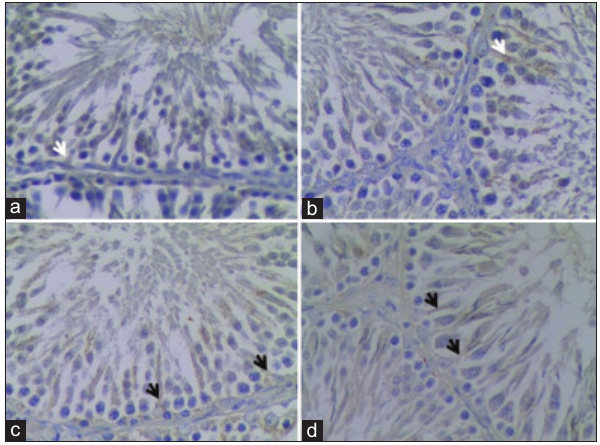
Figure-1: Micrographs of rat testicular tissue (original magnification, ×400). (a) The control group, (b) injected with 25 μ g cloprostenol. Both of these tissues revealed no difference in cyclic adenosine monophosphate response element modulator (CREM) expression in Sertoli cells (white arrow). (c and d) injected with 0.2 and 0,4 seminal vesicle extract, respectively – revealed an insignificant difference of the expression of CREM in Sertoli cells. Sections were counterstained with